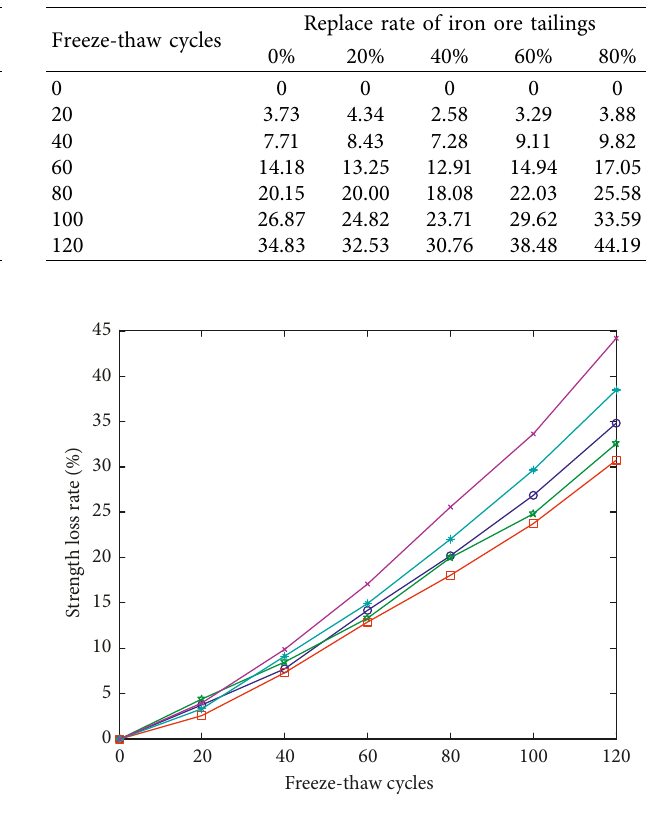
Table 6: Strength loss rate of C30 iron ore tailings concrete after freeze-thaw (%).